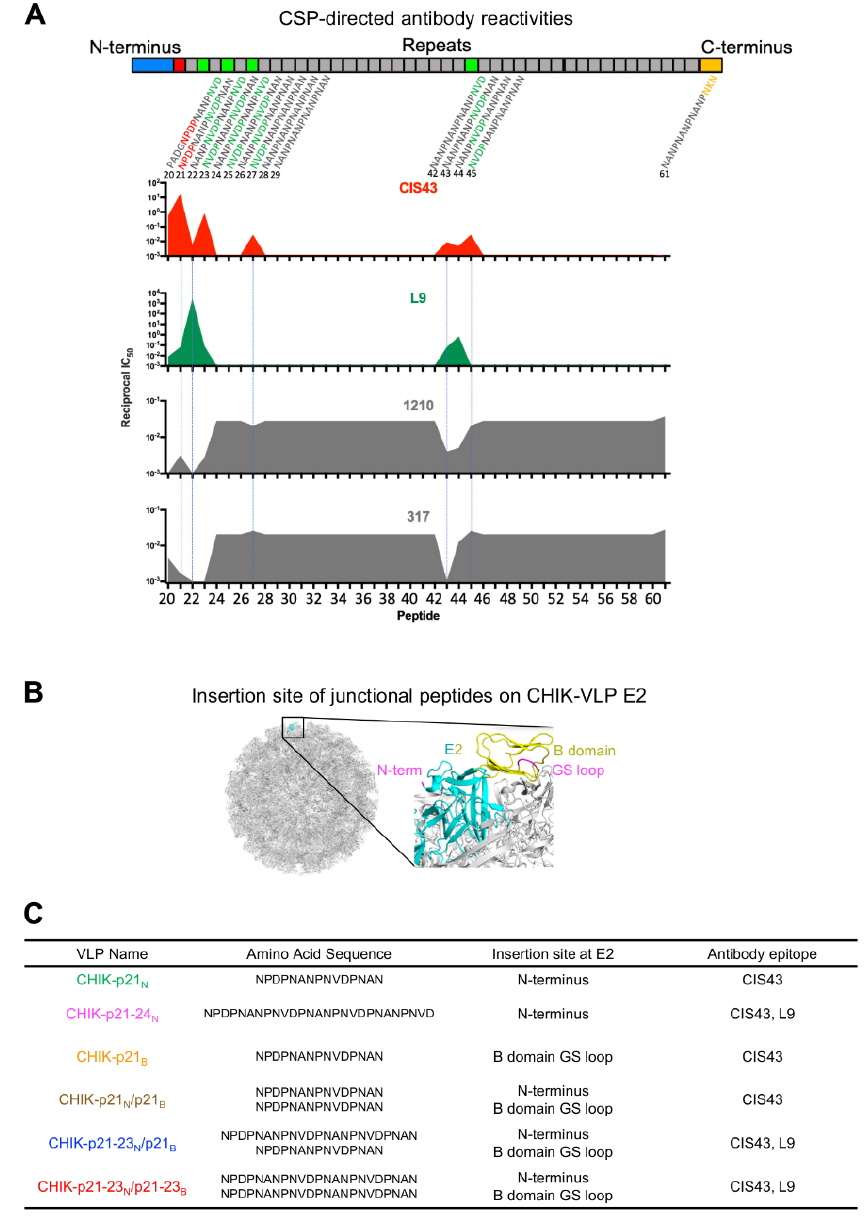
Figure 1. Design of chikungunya virus-like particles (CHIK-VLP) immunogens that incorporate CIS43 and L9 epitopes. ( A ) (Upper panel) Schematic of PfCSP. Tetrapeptide sequences NPDP (red), NVDP (green), and NANP (grey) are highlighted. (Lower panel) Epitope mapping of selected PfCSP repeat-directed mAbs based on competition of their binding to PfCSP by overlapping 15-mer peptides. ( B ) Location of N-terminus and B domain insertion regions on CHIK-VLP E2. ( C ) Summary of CHIK-VLP immunogens incorporating CIS43 and L9 epitopes to N-terminus and/or B domain of CHIK-VLP E2 developed in this study.